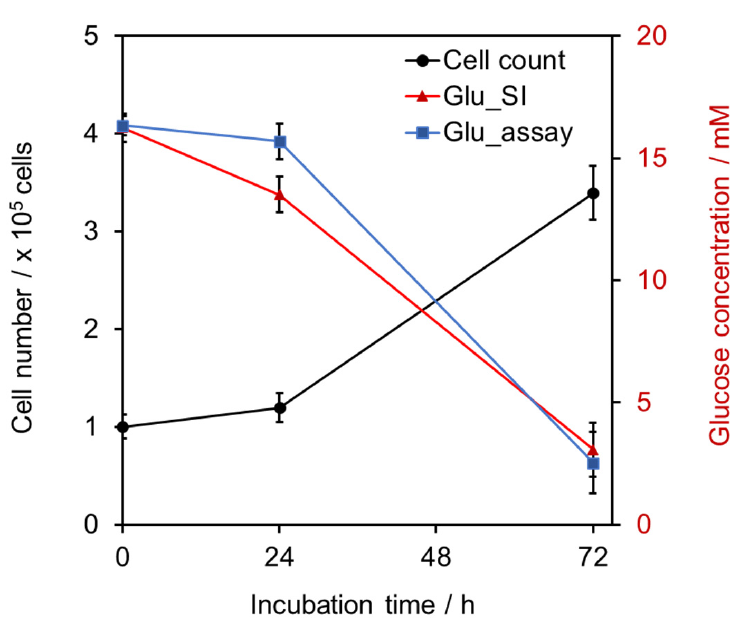
Figure 4. The relationship between glucose concentration in cell media determined by the developed system (red) and conventional enzymatic assay (blue) and the number of L929 cell (black) after incubated in the bioreactor for 72 h, n = 3.